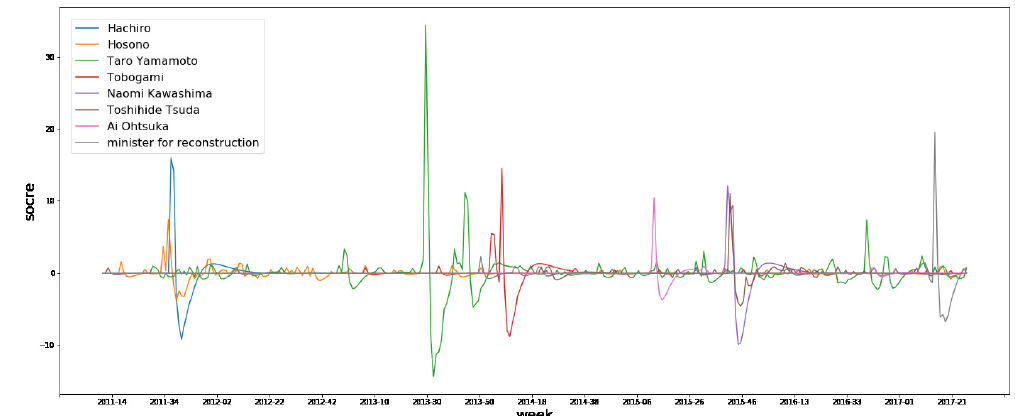
Figure 2. Plot of the scores of the top 9 words picked up in Table 4.